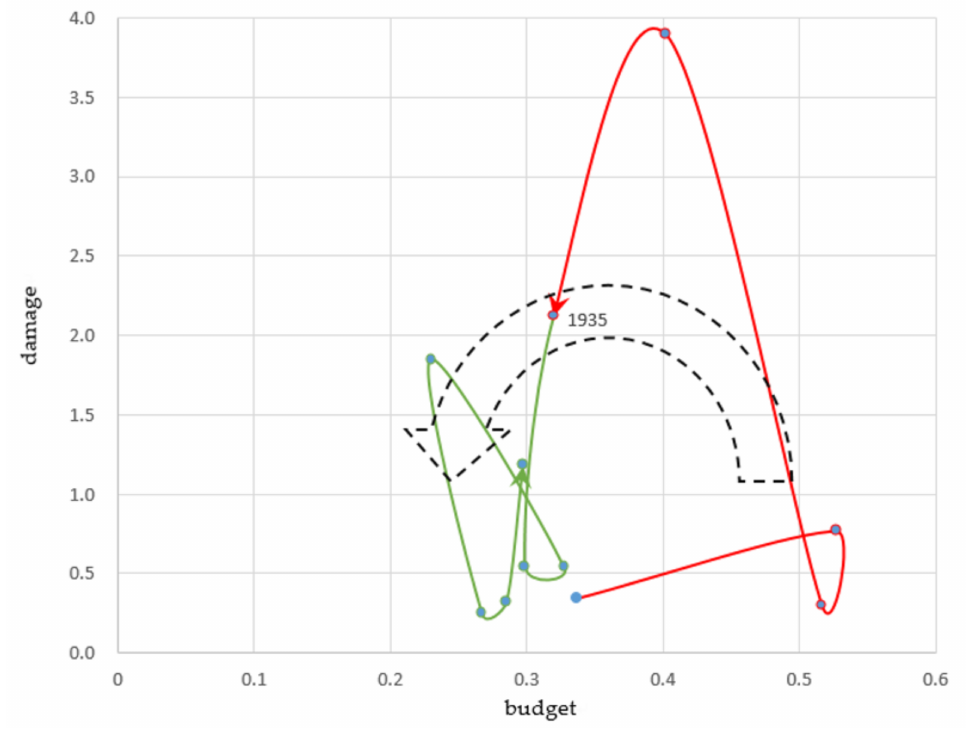
Figure 4. Third investment cycle 1931–1945 (Share of the National Income %). Source: Authors’ elaboration. Decreasing Budget